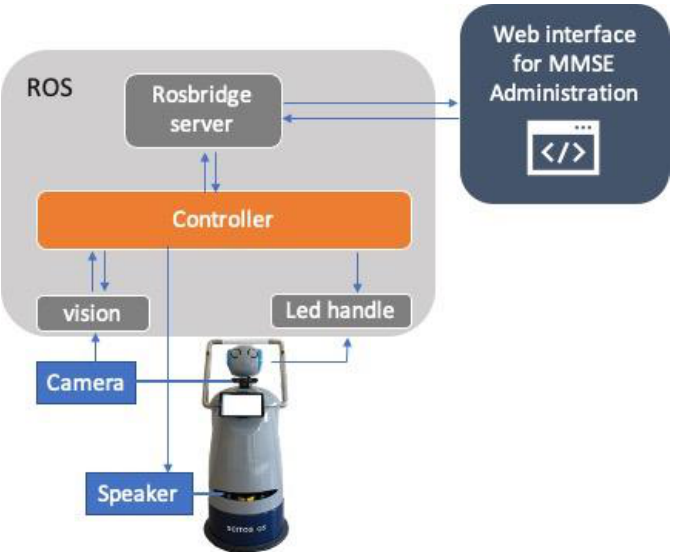
Figure 1. The architecture of the ASTRO robot.